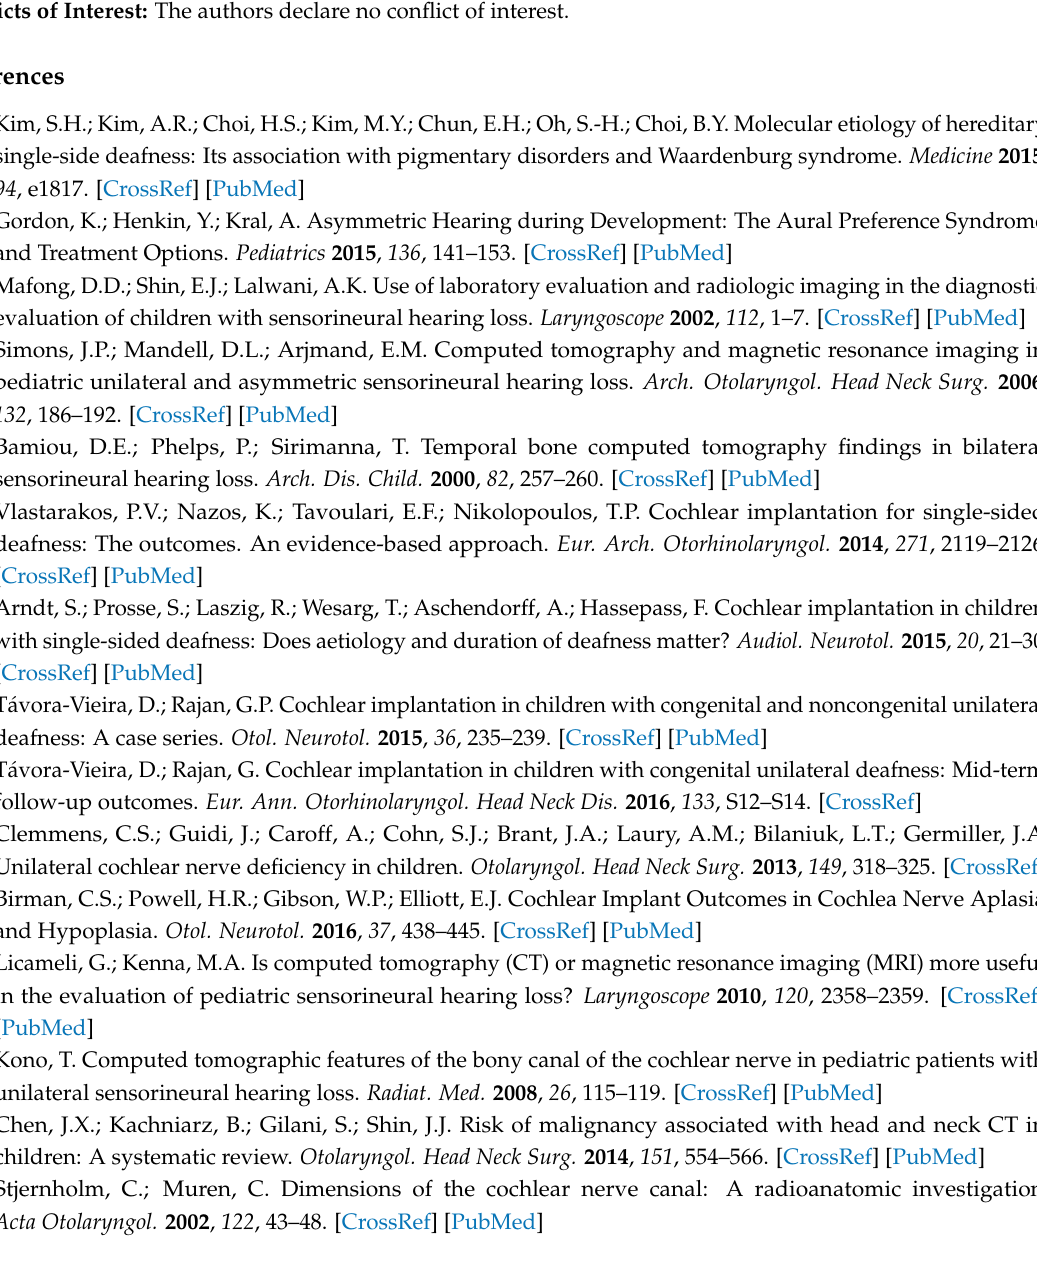
Figure S1: The measurement of BCNC and IAC diameter based on TBCT, Figure S2: Additional inner ear anomalies of pediatric patients with SSD based on TBCT, Figure S3: Additional inner ear anomalies of pediatric patients with SSD based on IAC